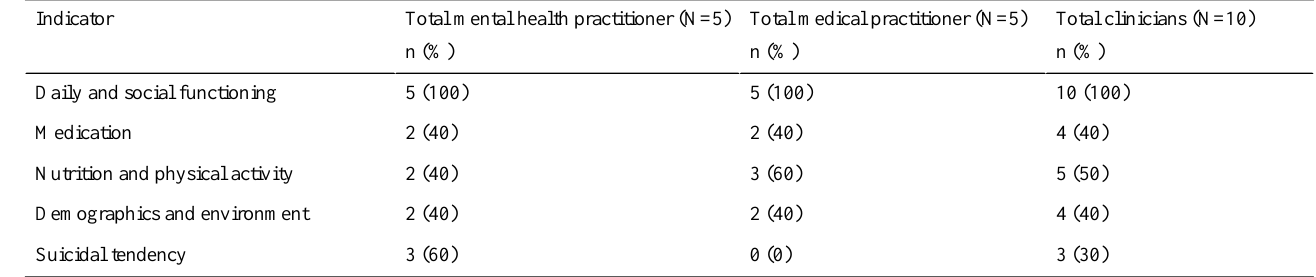
Table 2. Clinician-generated